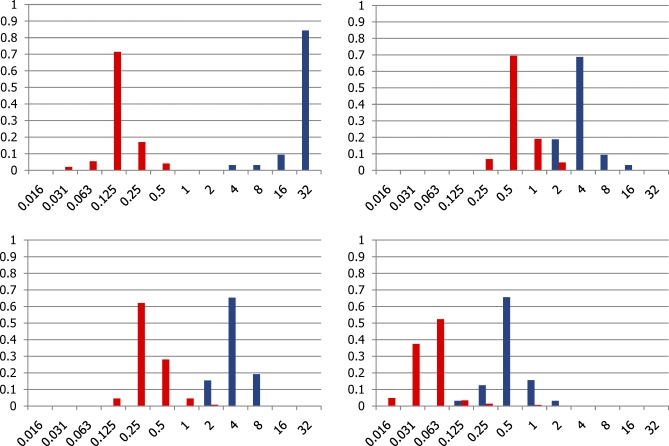
Distribution of Proportions of MICs of 32 ITZ+ A. fumigatus Isolates (Blue Bars) and 115 ITZ− Controls (Red Bars) of ITZ (left upper panel), Voriconazole (right upper panel), Ravuconazole (left lower panel), and Posaconazole (right lower panel)Left x-axis represents the proportion of isolates and on the right x-axis the MIC distribution is shown.